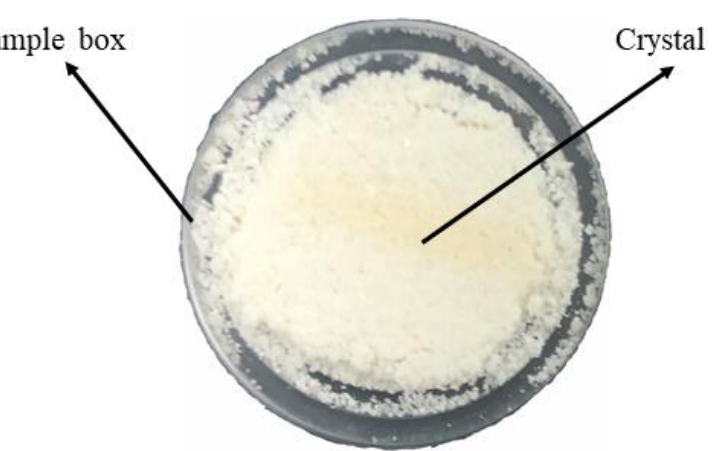
Figure 5. Temperature drop effect of the shell-and-tube circulating condenser.